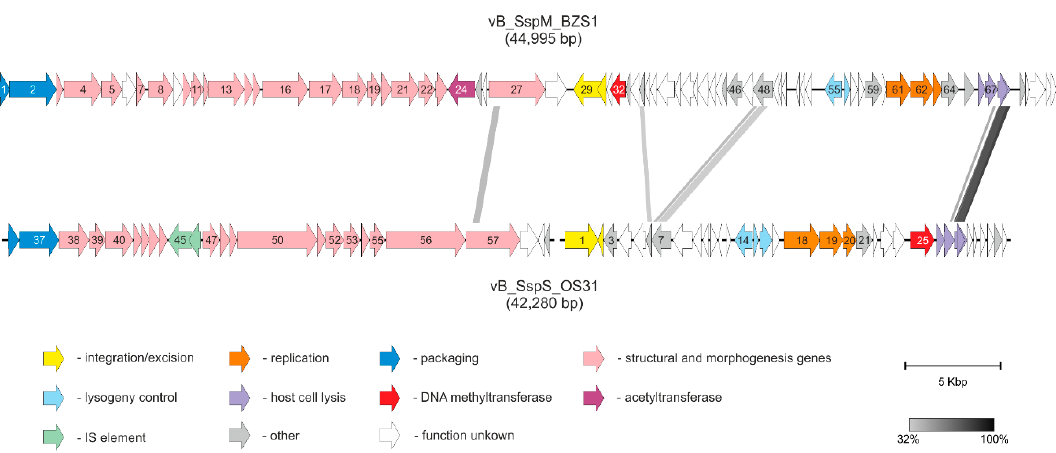
Figure 2. Genome organization and location of homologous proteins of vB_SspM_BZS1 and vB_SspS_OS31 phages. Arrows indicate transcriptional orientation of genes. Selected predicted protein functions are indicated by colored arrowed according to the legend. Numbers on arrows refer to locus tags, i.e., PhiBZS1_pX or PhiOS31_pX, where X refers to gene number in Tables S2 and S3. Additionally, lines connecting BZS1 and OS31 arrows reflect protein sequence similarity according to